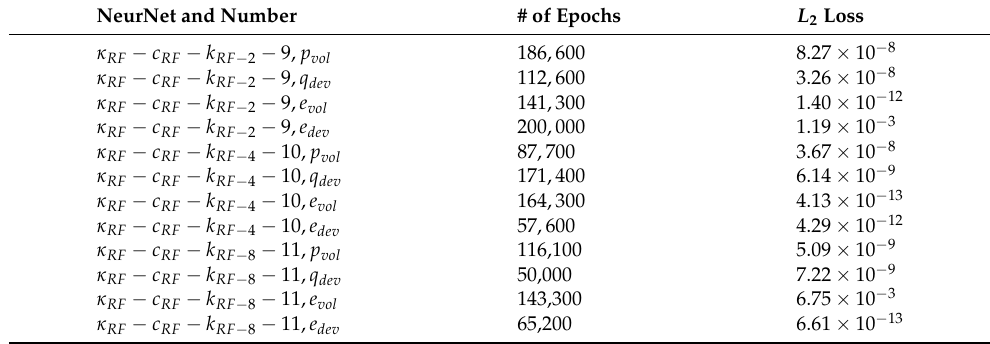
Table 5. Number of epochs for convergence and the corresponding L 2 loss for Neural Networks for Monte Carlo simulations of porous analyses with stochastic spatial representation for all the stochastic material variables.